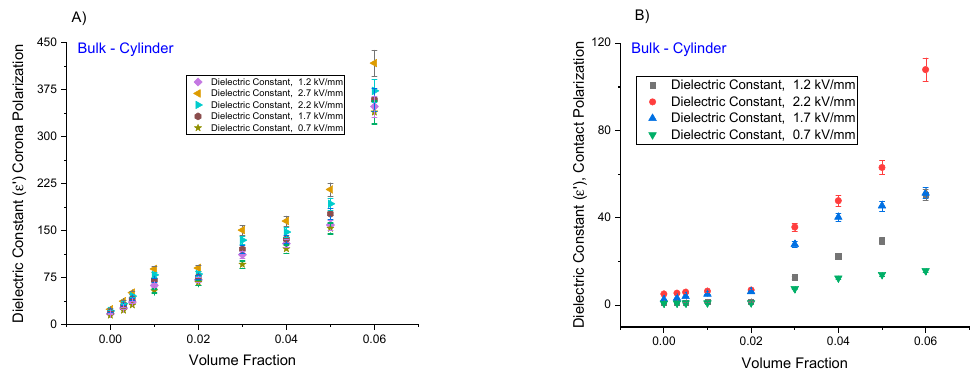
Figure 2. Variation in the dielectric constant as a function of polarization voltage and volume fraction of MWCNTs for corona ( A ) and ( B ) contact polarization techniques applied to bulk samples.